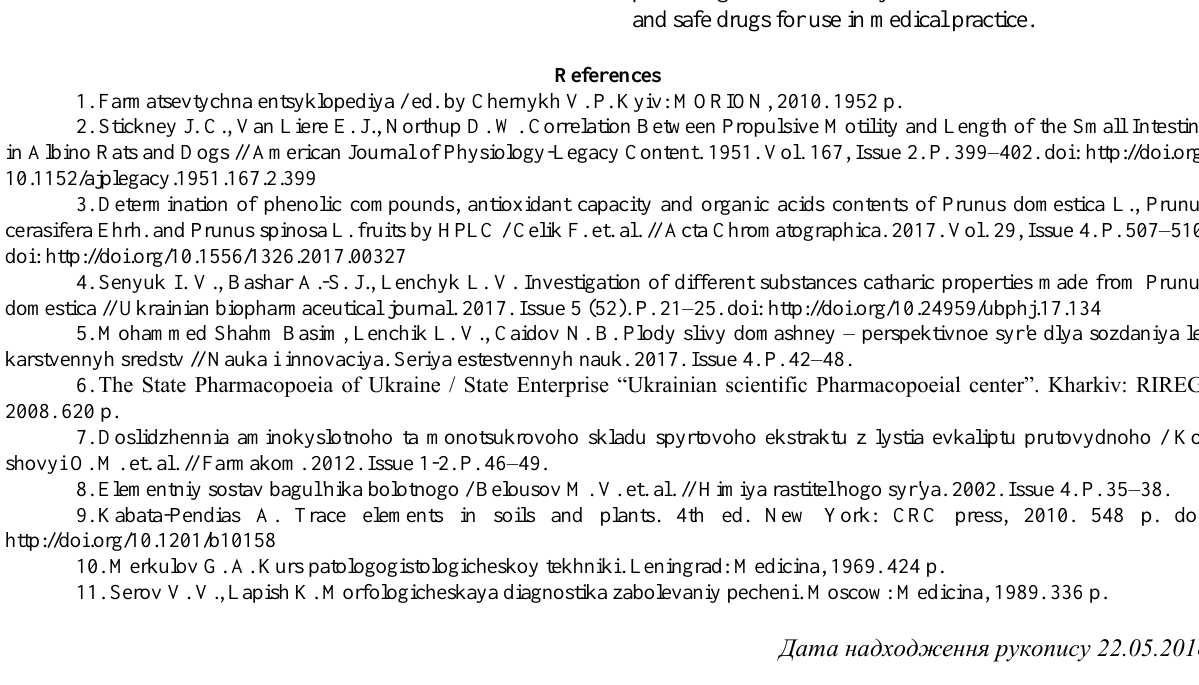
Fig. 9. Rat liver, which on the background of ethyl alco- hol injected silibor. The protein pattern is unchanged, small vacuoles in the cytoplasm of virtually all hepato- cytes Hematoxylin-eosin. ×250